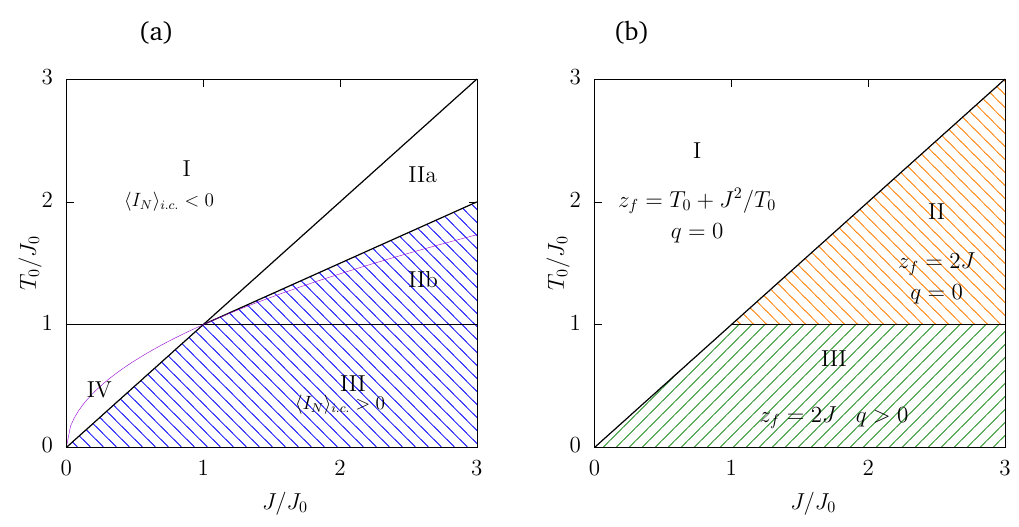
Figure 4: Properties in parameter space. (a) Sign of the last conserved quantity, 〈 I 〉 / J } plane. Below the horizontal line , in different sectors of the { T , J / J N i . c . 0 0 0 = J 〉 = ( N ) . In the full white region 〈 I 〉 < 0 while in the blue dashed T , 〈 I N i . c . N i . c . 0 0 O 〉 > 0. The violet solid line represents T / J = ( J / J ) 1 / 2 . 〈 I 〉 = 1 for all part 〈 I µ N i . c . i . c . 0 0 0 µ on this curve in phase II but they keep a µ dependence on the curve’s continuation in phase IV. (b) The dynamical phase diagram obtained in [ 10 ] from the study of the asymptotic limit of the Schwinger-Dyson equations coupling correlation and linear response in the strict thermodynamic limit. The labels in the three phases display the values of the asymptotic Lagrange multiplier, z , and the limit of the self time- f = 1 / T delayed correlation function q . The static susceptibility equals χ to the left st 0 = 1 / J to the right of it. q ≡ lim C ( t ,0 ) (cid:54) = 0 in III and of the diagonal and χ t →∞ st 0 〉 and 〈 p 2 〉 we were able vanishes elsewhere. From the analysis of the scaling of 〈 s 2 N N to identify phase IV, see Section 5 and Fig.